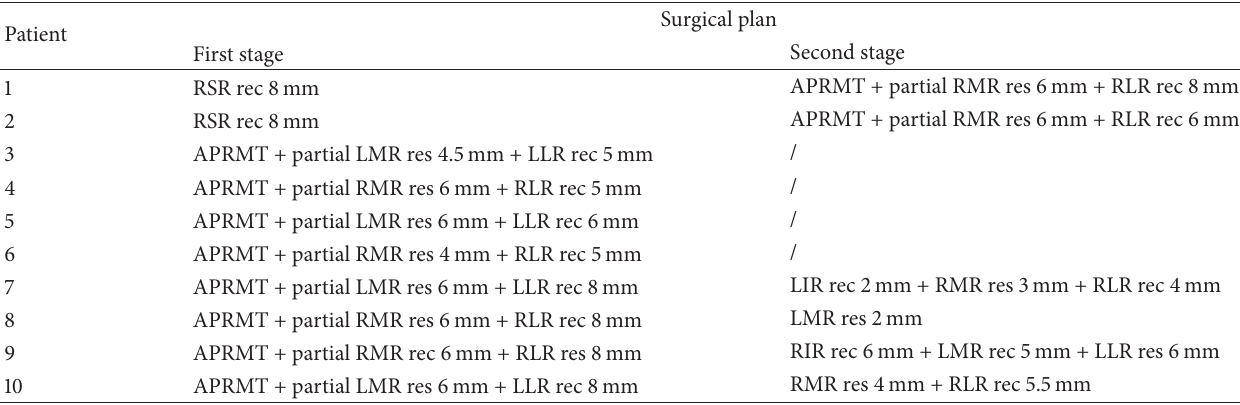
Table 2: Surgical dosing used in the 10